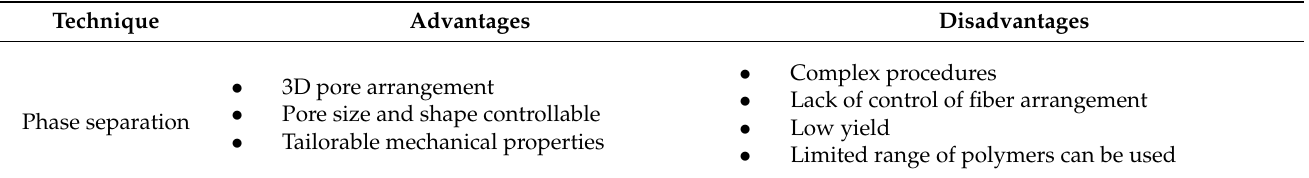
Table 2. Advantages and disadvantages of three different scaffold techniques.